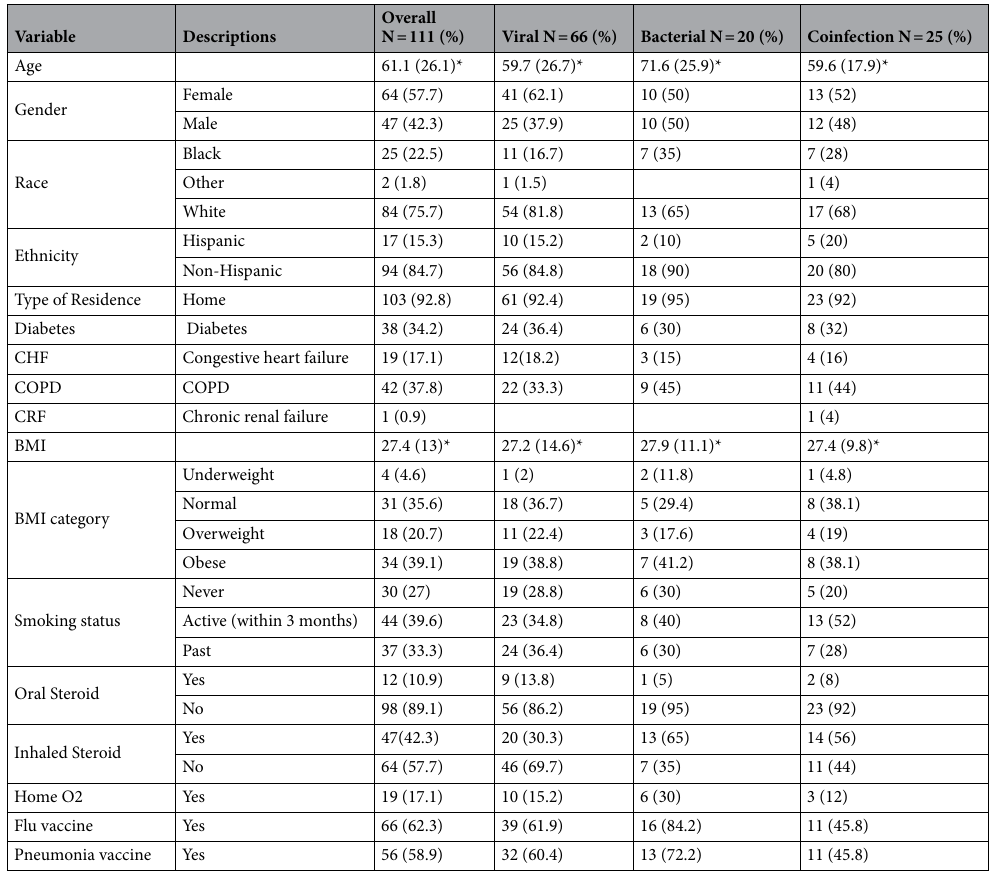
Table 1. Patient characteristics. *Age and BMI are Median (interquartile range).